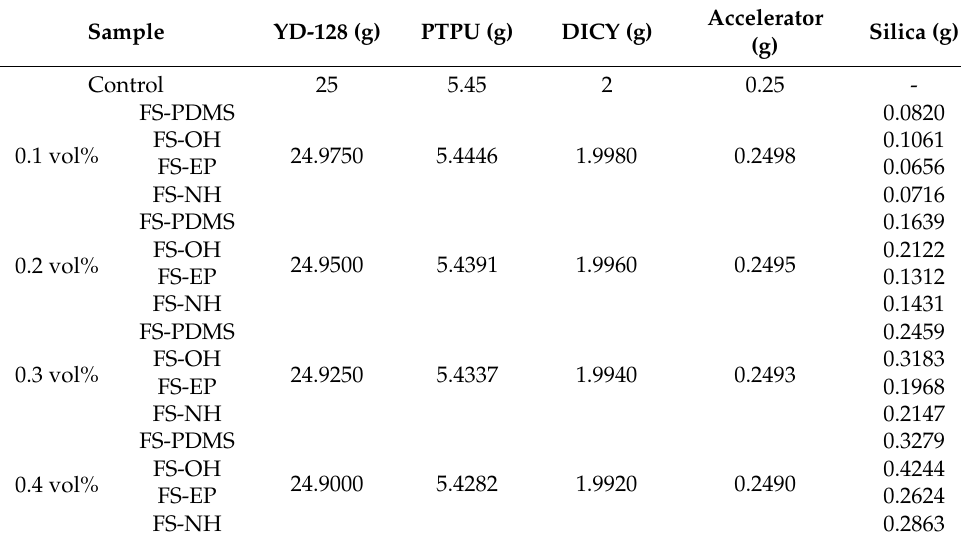
Table 2. Composition of silica-modified epoxy